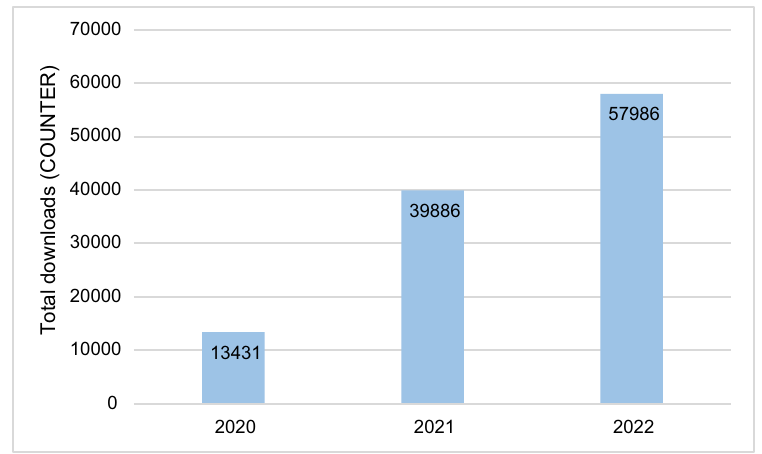
Figure 7. Number of downloads per